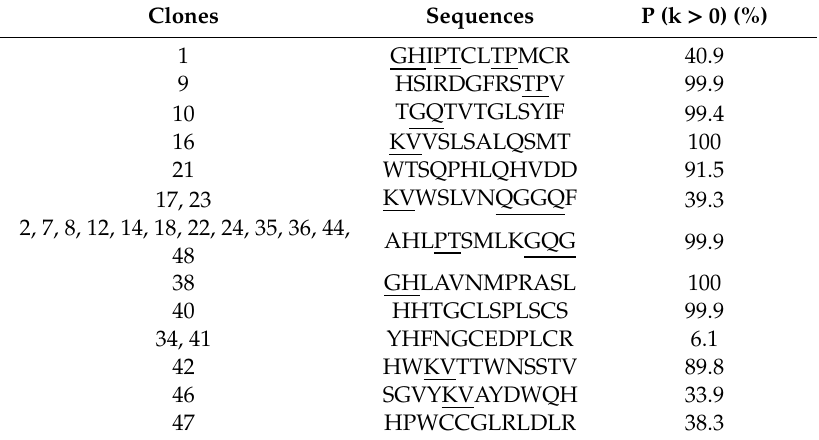
Table 1. Amino acid sequences obtained from the 29 selected clones and their probability to be expressed in the phage display library (P). Consensus motifs are underlined, whereas Cys pairs are shown in